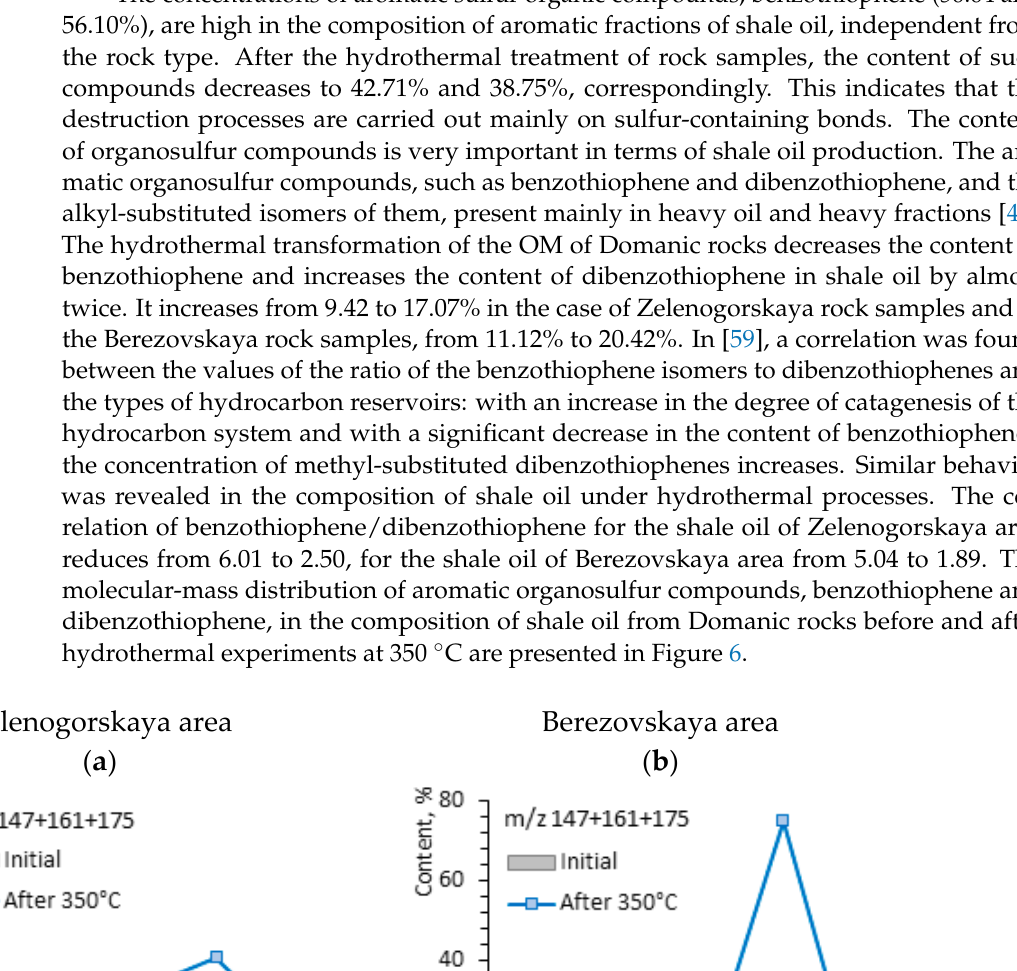
Figure 5. TIC of aromatic fractions of shale oil from the rock samples of Zelenogorskaya and Berezovskaya areas before ( a , c ) and after ( b , d ) hydrothermal experiments. N—naphthalene, P—phenanthrene, DBT—dibenzothiophene and BT— benzothiophene, n—number of carbon atoms in alkyl substitutes of C